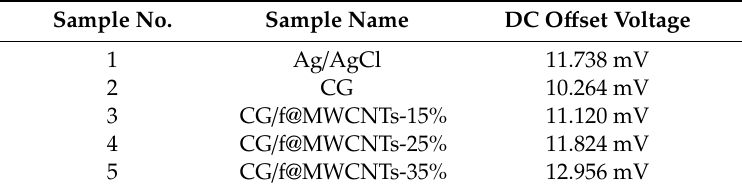
Table 1. DC o ff set voltage of commercial and fabricated electrodes.